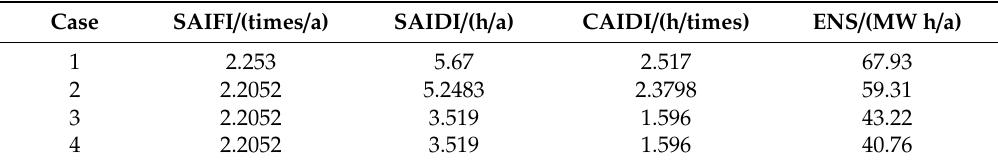
Table 2. System reliability index (SAIFI, system average interruption frequency index; SAIDI, system average interruption duration index; CAIDI, customer average interruption duration index;